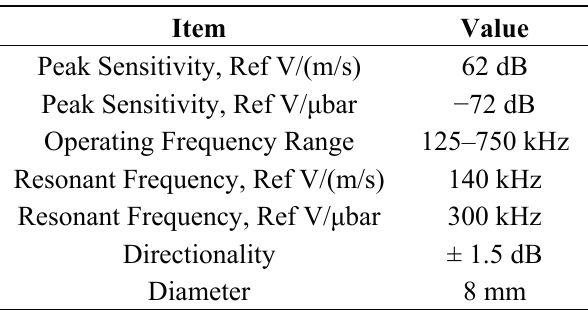
Table 3. Sensor main technical features.